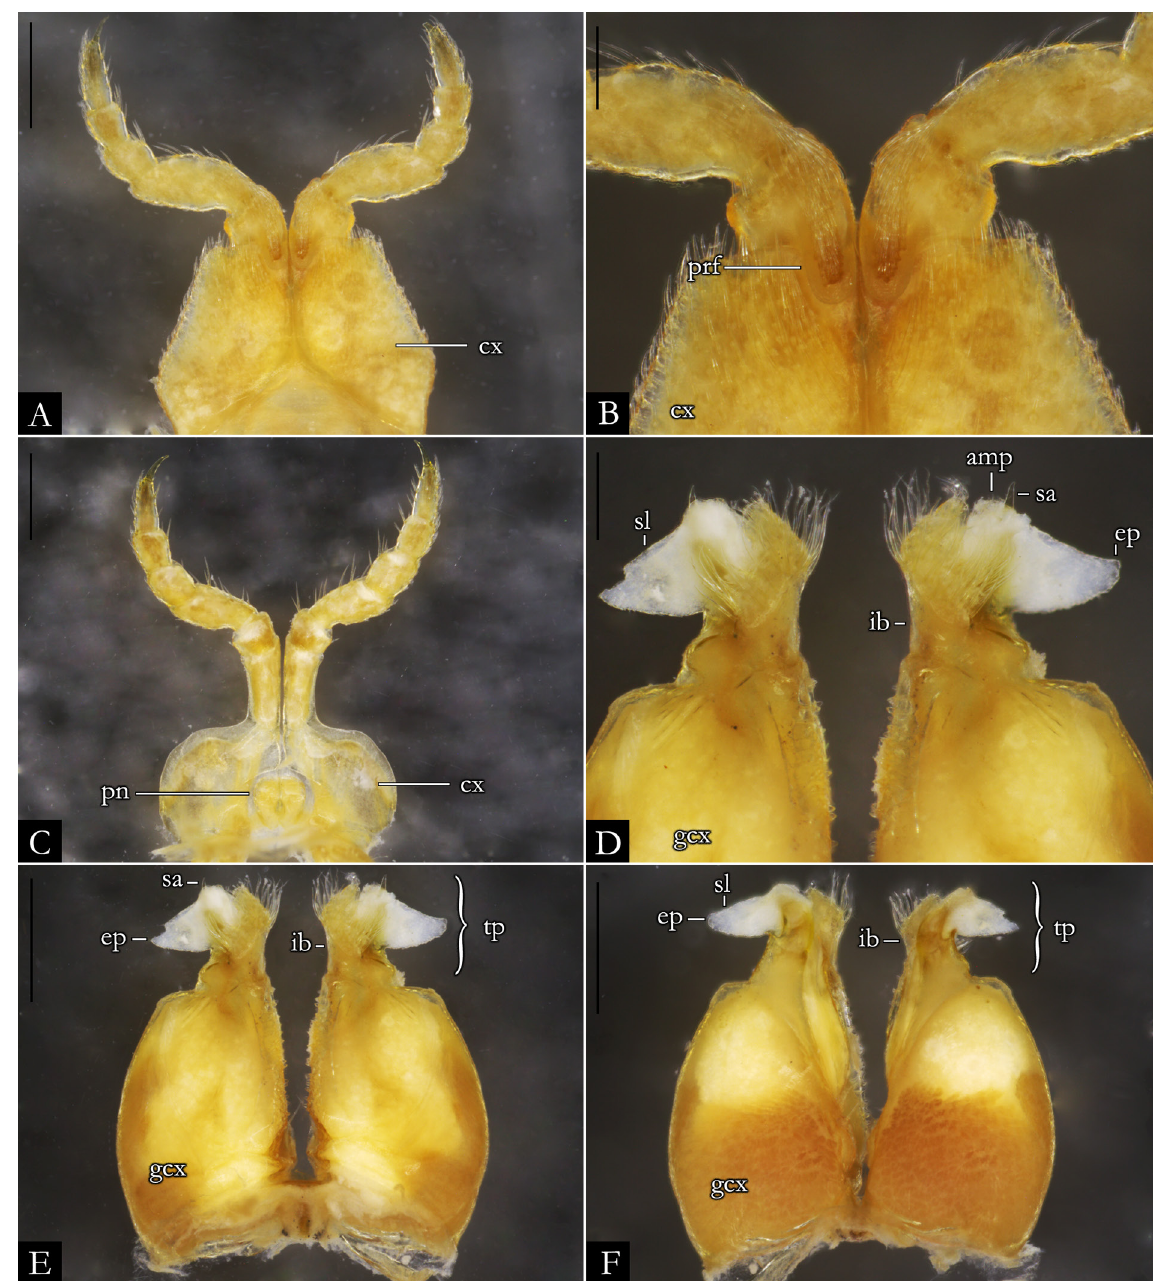
Fig. 75. Pseudonannolene inops Brölemann, 1929, ♂ (IBSP 2559). A . First leg-pair. B . Detail of prefemur. C . Second leg-pair. D . Detail of telopodites, in anal view. E . Gonopods, in anal view. F . Gonopods, in oral view. Abbreviations: see Material and methods. Scale bars: A, E–F = 0.5 mm; B–D = 0.2